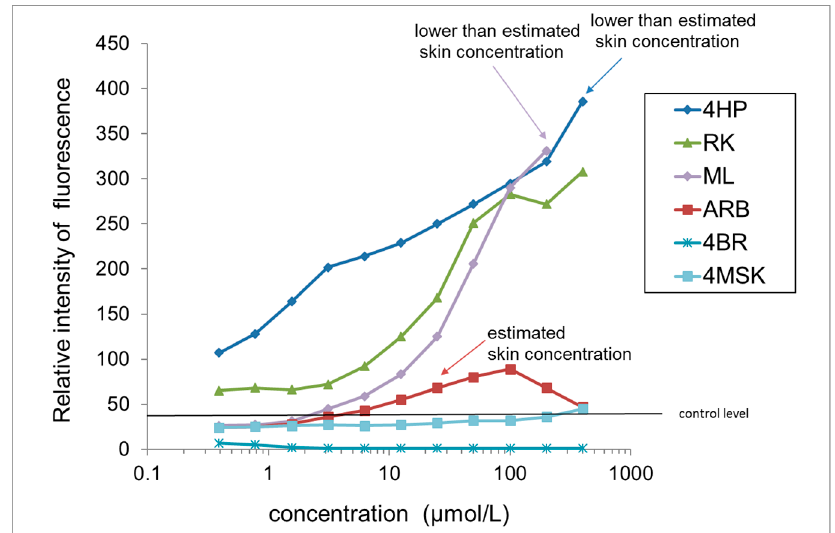
Figure 5. Comparison of · OH generation by test ingredients in the presence of tyrosinase. Results are presented as the mean of three experiments. 4HP, rhododendrol; RK, raspberry ketone; ML, magnolignan; ARB, arbutin; 4BR, 4-n-butylresorcinol; 4MSK, 4-methoxysalicylic acid potassium salt.